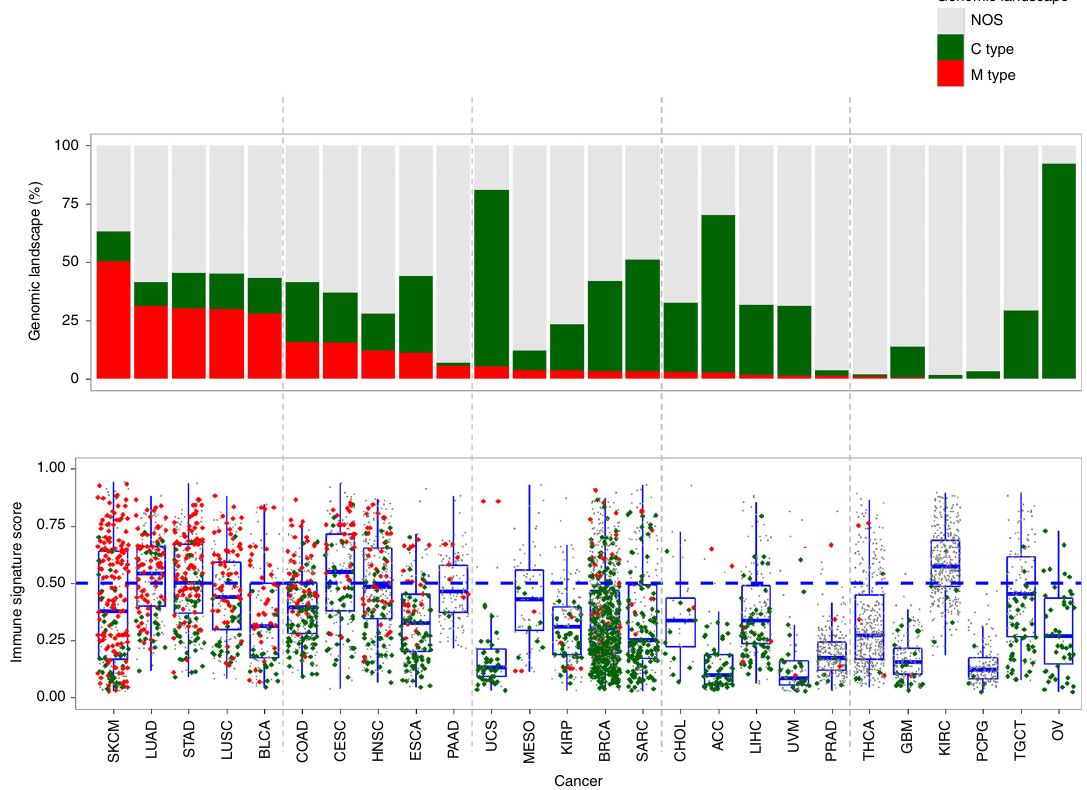
Fig. 5 Distribution of genomic cancer types in each cancer. (top) A systematic overview of proportion of mutator type tumors (M type, red), chromosome- instable tumors (C type, green), and not otherwise speci fi ed (NOS) (bottom) immune signature (IS) score in each cancer. Blue lines in the box represent upper 75%, median, and lower 25% values of cancer type. Abbreviation of cancer type was referred from The Cancer Genome Atlas tag